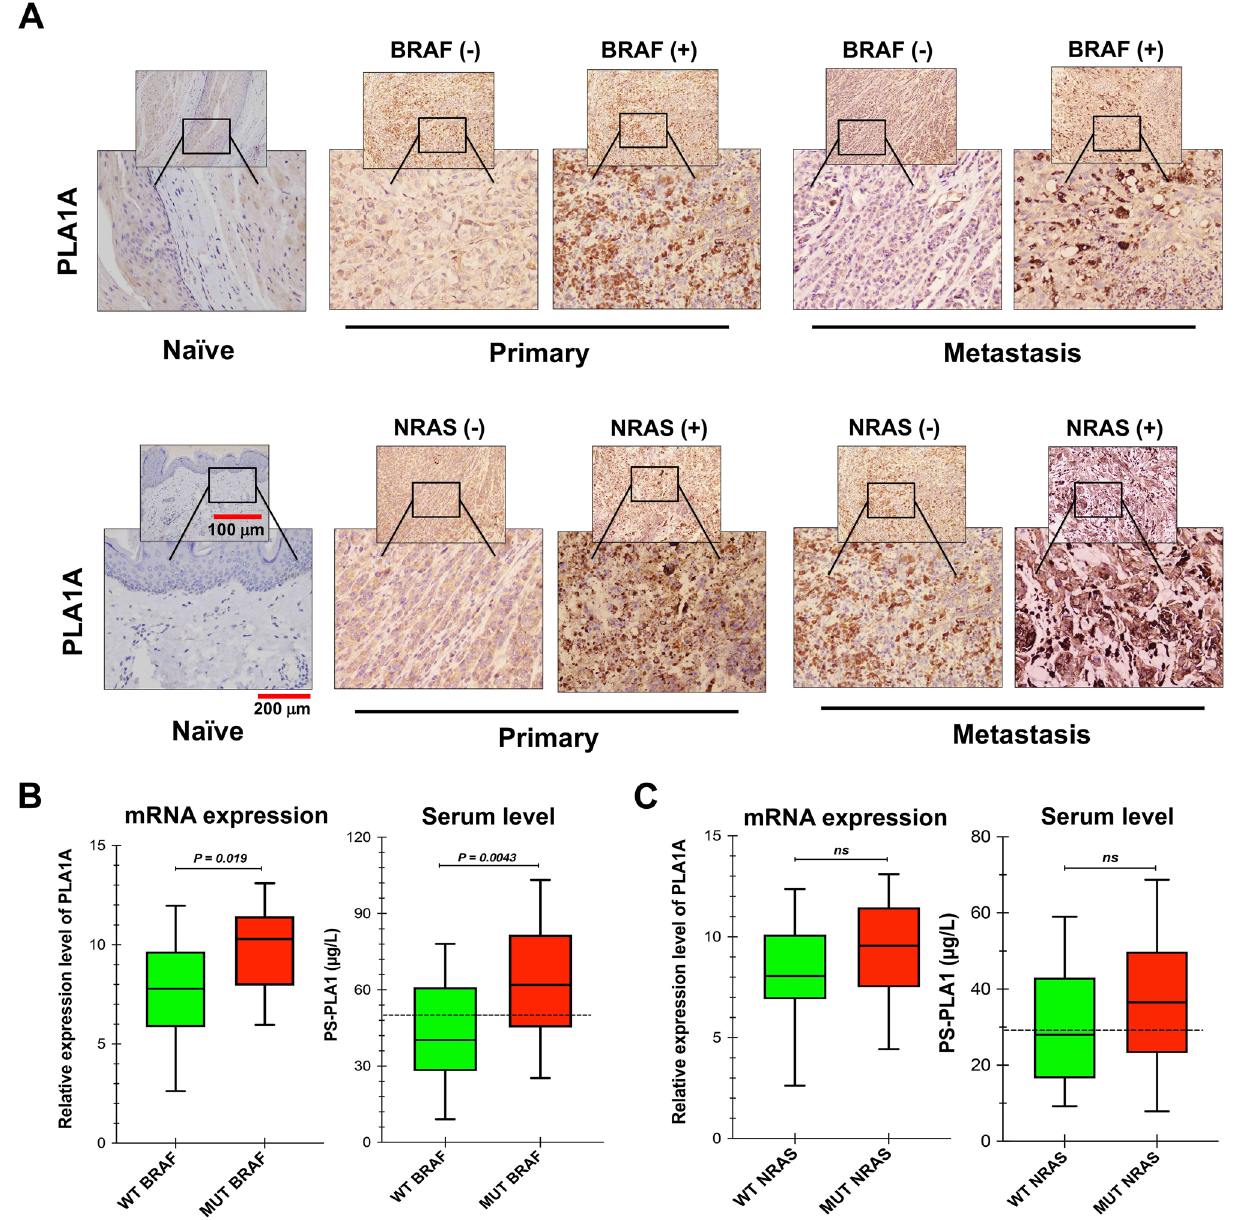
Figure 4. PLA1A expression in BRAF- and NRAS-mutant subjects with melanoma. ( A ) Gallery of representative immunostaining of PLA1A expression in BRAF-WT/MUT type (orange) and NRAS-WT/MUT among naïve, primary, and metastatic groups. Patents with wild and mutant type are represented by the blue and orange box, respectively. ( B ) The histogram shows the frequency of PLA1A mRNA expression and serum levels between BRAF-WT (green) and BRAF-MUT (Red) type of patients. ( C ) Distribution of PLA1A expression in patients with NRAS-WT (green) and NRAS-MUT (Red) patients with PLA1A1-high tumors had significantly shorter DFS compared to that in patients with PLA1A-low tumors (5-year DFS rate: 69.3% vs 75.4%, p = 0.026) (Fig. 5A). This result indicated that the prognosis of patients with high-PLA1A tumors was worse compared to that of patients with low-PLA1A tumors ( p < 0.05, Fig. 5A). The correlation between different stages of melanoma and 5-year DFS is shown in Fig. 5B. The area under the curve (AUC) of the receiver operating characteristic (ROC) analysis of naïve/primary, naïve/metastasis, and primary/metastasis group was 0.99, 0.99, and 0.67, respectively. The analysis based on specimen types indi- cated that PLA1A had a relatively accurate diagnostic value in discriminating the naïve melanoma samples from advanced melanoma samples, with a sensitivity of 0.91 and specificity of 0.57 (Fig. 5B and Supplementary Fig. 3). By considering both PLA1A mRNA and serum levels, the univariate analysis among BRAF/NRAS mutated sam- ples demonstrated that PLA1A was more accurate for BRAF-MUT samples compared to NRAS-MUT samples (Fig. 5C). As shown in Fig. 5C and Supplementary Fig. 3B, the pooled sensitivity and specificity were higher in